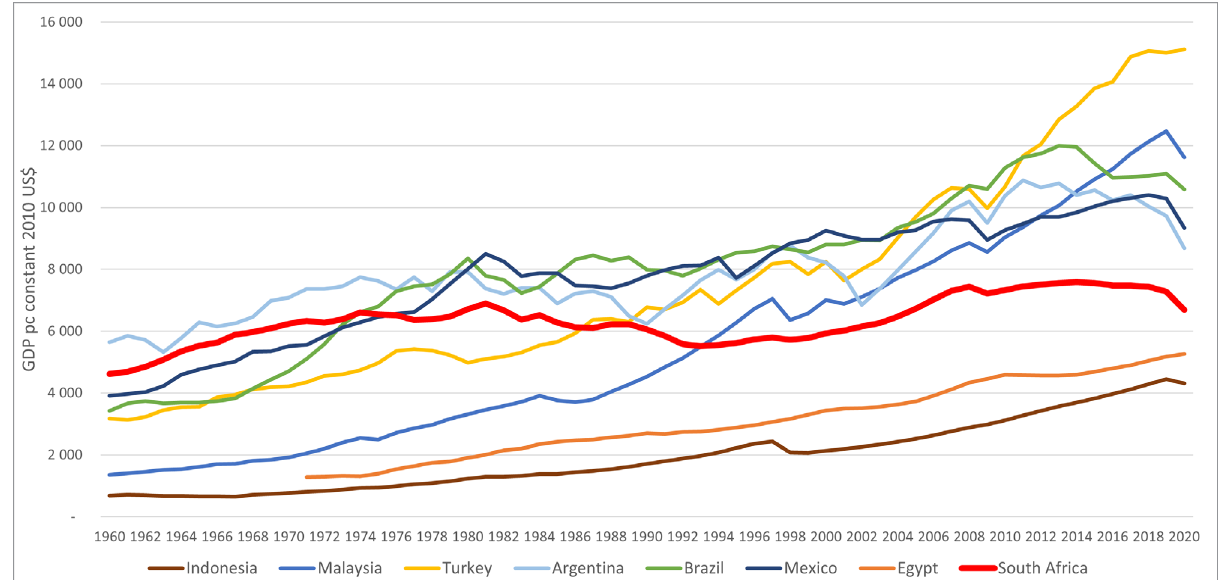
GDP per capita in comparative emerging economies (1960–2020). 16